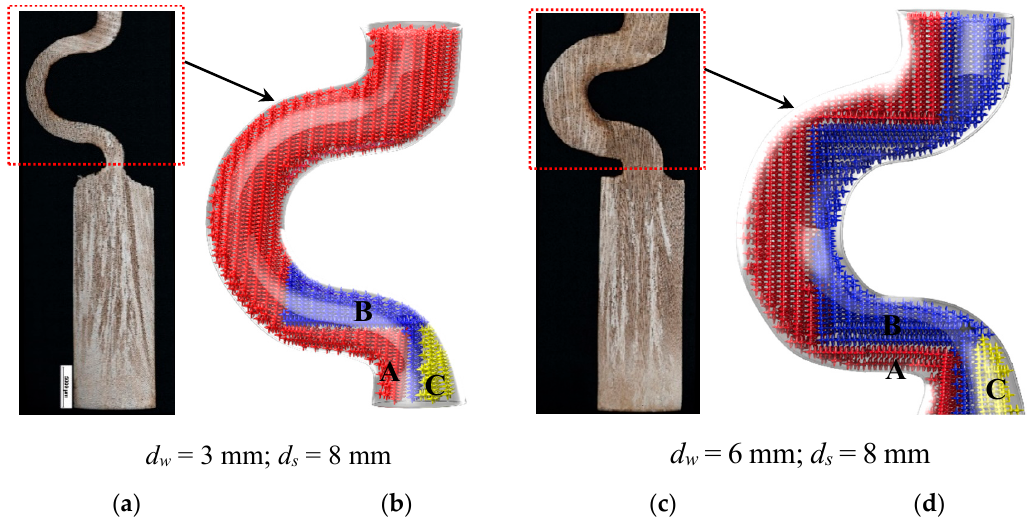
Figure 5. Optical images of the dendrite structure in the selector parts of the selectors with 3 mm ( a ) and 6 mm ( c ) thickness as well as their corresponding schematic diagrams ( b ) and ( d